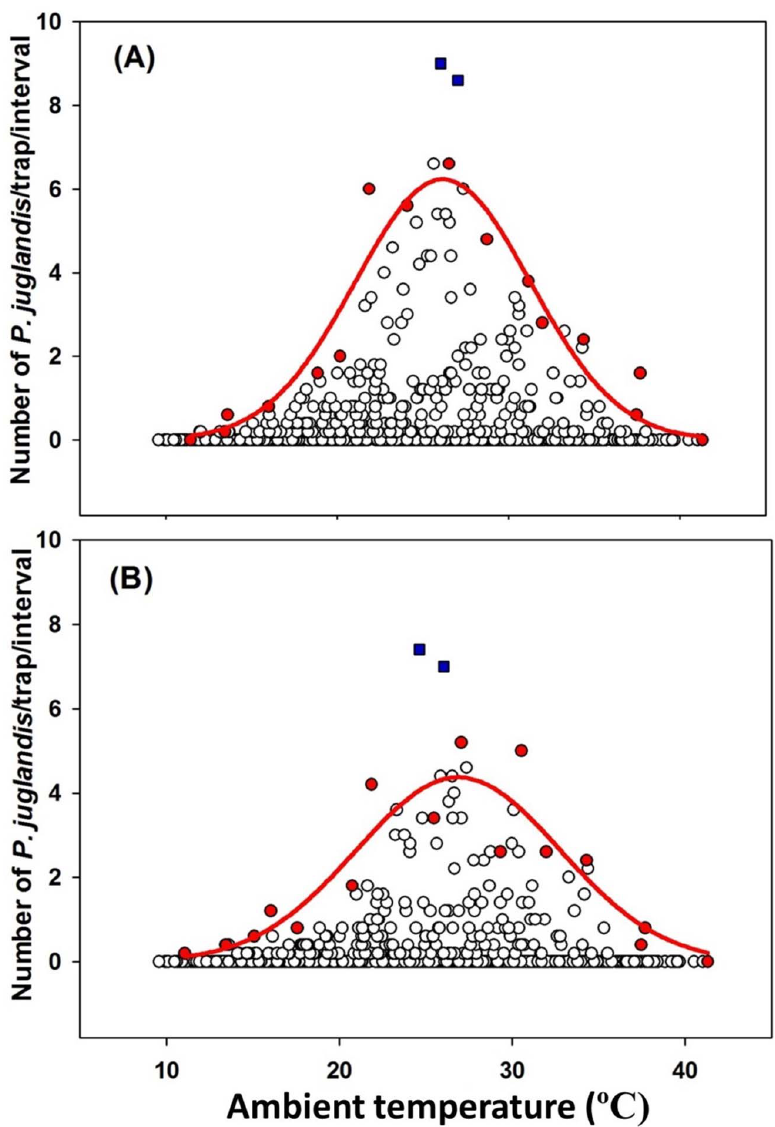
Figure 4. The Gaussian relationship ( Y = a 6 exp ( 2 ( X 2 X0 ) 2 /2 b )) between Pityophthorusjuglandis catches and temperature ( 6 C). (A) Female: N =855, F =63.38, P , 0.001, a =6.23, b =5.11, X 0 =26.16, adj. R 2 =0.89; (B) Male: N =855, F =28.87, P , 0.001, a =4.37, b =5.89, X 0 =26.87, adj. R 2 =0.79. Blue % : Outliers; Red q : Data points used to fit curves. These points were the greatest values of trap catches from each of the temperature classes